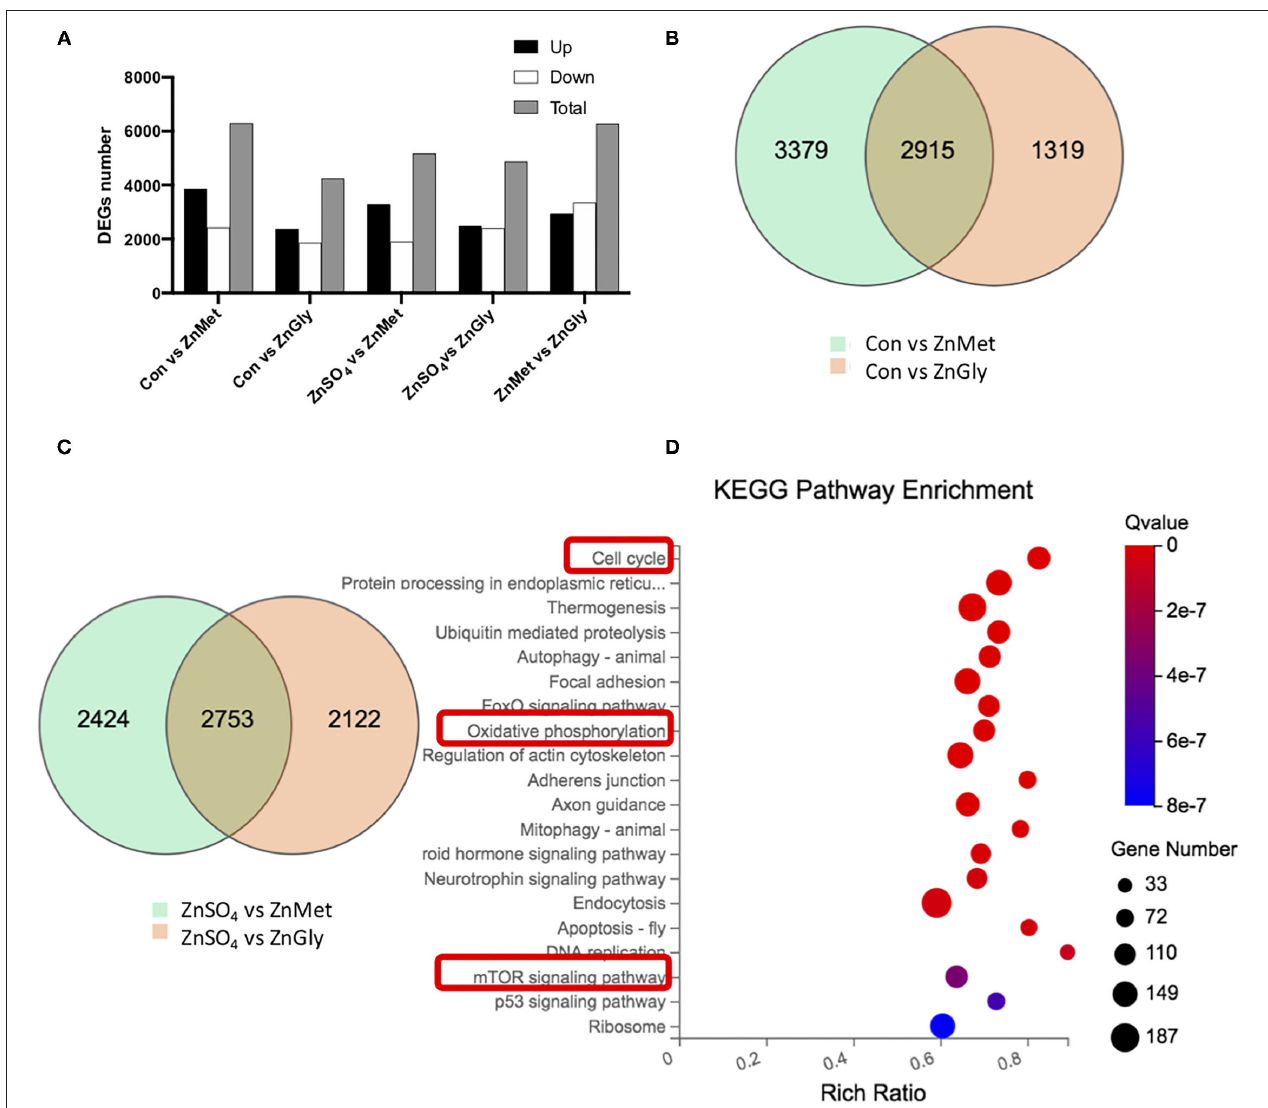
FIGURE 2 | The numbers (A) , Venn diagram (B,C) of differentially expressed genes (DEGs), and top Kyoto Encyclopedia of Genes and Genomes (KEGG) pathways of DEGs (D) in C2C12 cell line by adding different zinc sources.